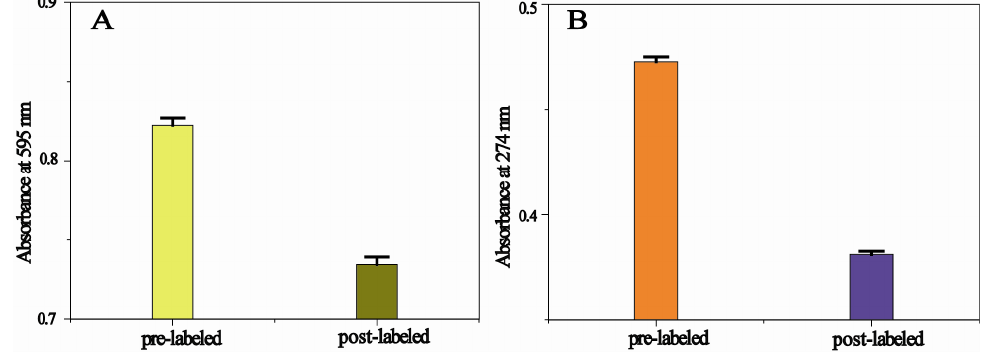
Figure 2. ( A ) Absorbance readings taken at 595 nm, following Coomassie Brilliant Blue G-250 staining, to observe the amount of Ab ( B ) Absorbance readings taken in the UV-Vis spectra (274 nm), for the detection of binding of glucoamylase to AuNPs.